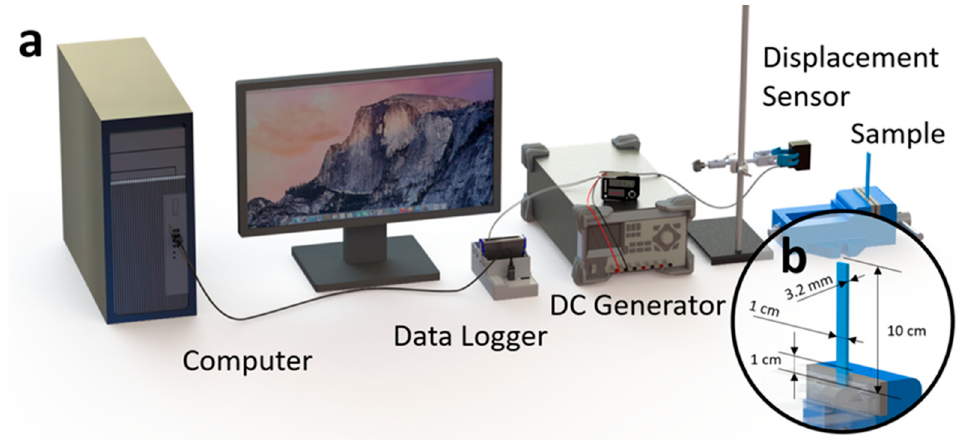
Figure 4. Apparatus used for experimental model analysis of 3D printed specimens: ( a ) an illustrative figure showing the connection and configuration of the experiment setup and ( b ) the design and configuration of the 3D printed cantilever and its clamping conditions.